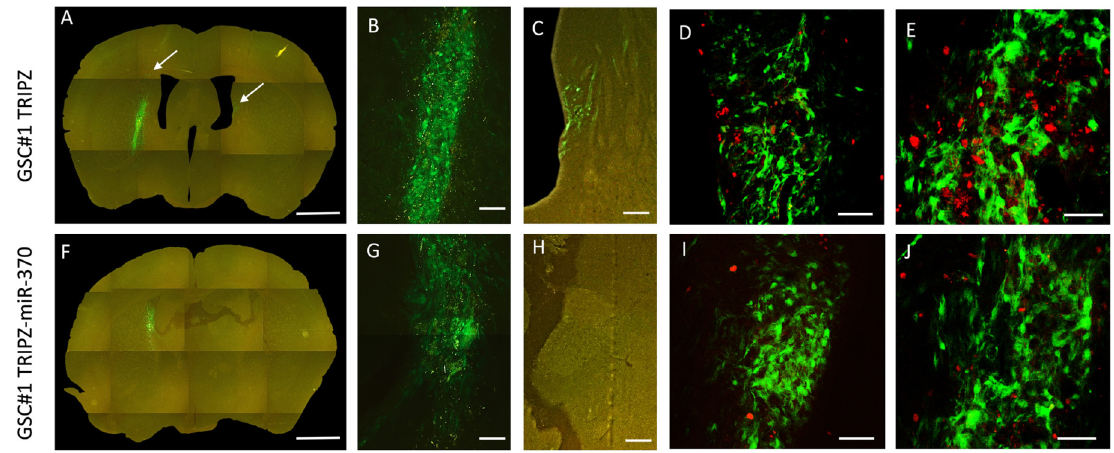
Figure 2. Restoration of miR-370 inhibits tumor growth in orthotopic xenograft mouse models. Fluorescence microscopy of mouse brain grafted onto the right striatum with GSC#1 cells. Upper panel , Photomontage of coronal section in a TRIPZ xenograft ( A ) showing the injection area ( B ) and tumor spreading to the subventricular zone of the contralateral hemisphere ( C ). The arrows point to tumor cells. Lower panel , Photomontage of coronal section in a TRIPZ-miR-370 xenograft ( F ). A few tumor cells with cell debris are found in the injection area ( G ). There is no contralateral spreading of tumor cells ( H ). Scale bars. A and F, 1 mm; B and G, 135 µ m; C and H, 150 µ m. Ki67 immunostaining showing positive nuclei of proliferating cells ( red ) in a TRIPZ xenograft ( D – E ) and in a TRIPZ-miR-370 xenograft ( I – J ). Scale bars. D and I, 90 m; E and J, 70 m.